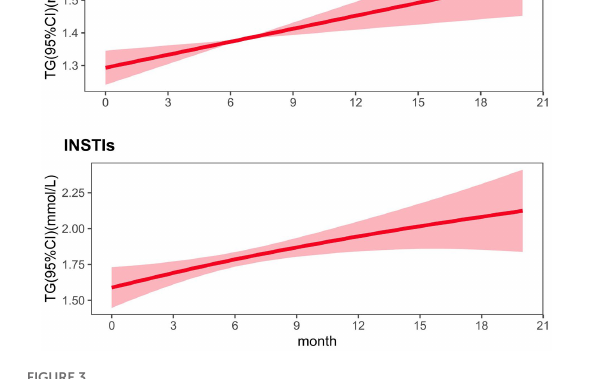
FIGURE 3 Fitted value changes in triglyceride (lines) over time and corresponding 95% CIs (shaded areas), stratified by types of ART regimen. The results were based on a generalized additive mixed model adjusted for age, gender and BMI. ART antiretroviral therapy, GAMM generalized additive mixed model, CI confidence